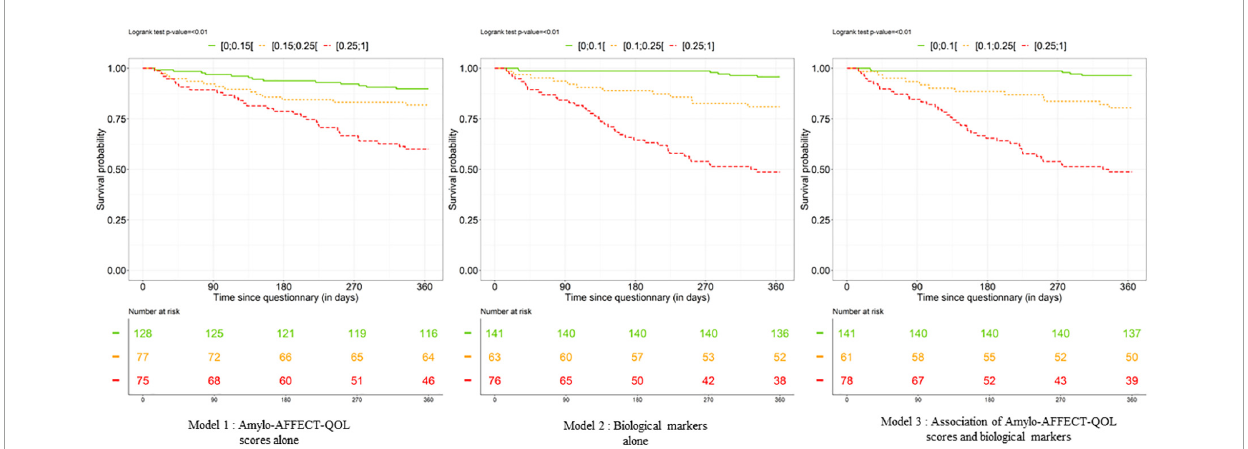
FIGURE2 Kaplan–Meier curves describing the link between death or heart transplant and the «calculated» prognostic values (green line represents 50% of patients, orange represents 25% of patients, and red represents 25% of patients) for each model (Amylo-AFFECT-QOL scores alone, biological markers alone, and Amylo-AFFECT-QOL scores and associated biological markers). The lower the prognostic value, the worse the prognosis.